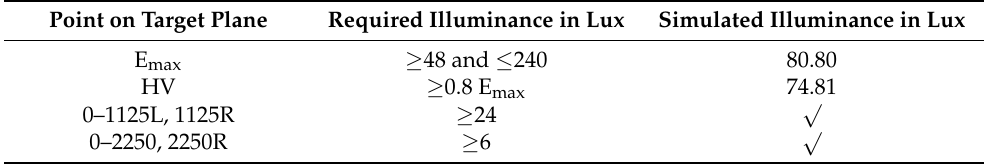
Table 2. Simulated illuminance values of high beam on the target